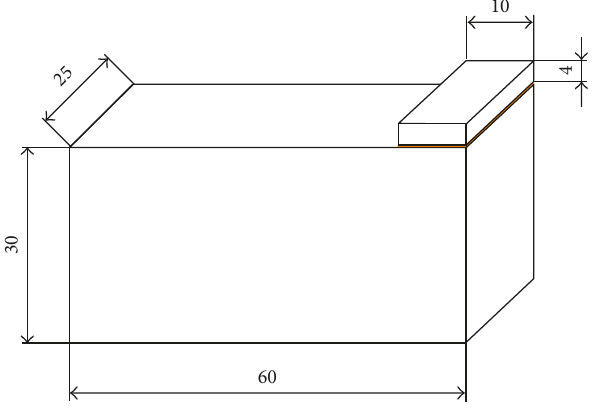
Figure 1: Dimensions of block samples.